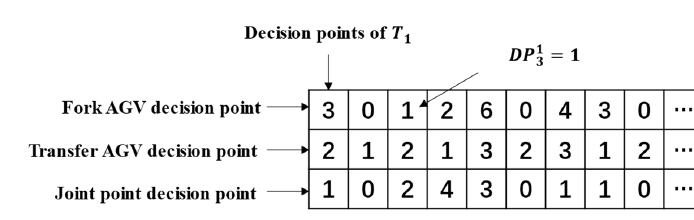
Fig.6. The decision points of a material transportation